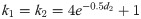
Comparison of effects between the cases of tracking (r > 0) and non–tracking (r = 0): inline–type structure.(A,B) dependence of mean expression and noise intensity on the green loop length for a fixed tracking ratio (r = 0.1), where the dashed lines correspond to the side-by-side loops; (C,D) dependence of mean expression and noise intensity on tracking ratio for a fixed green loop length; (E,F) three–dimensional pseudo diagrams for dependence of the mean expression level/the noise intensity on both the loop length and the tracking ratio, where the color change in the bar represents the change in the mean level or in the noise. Parameter values are set as d1 = 1500, λ21 = λ32 = λ34 = λ41 = 0.3, μ = 10, δ = 1, r = 0.1, k1=k2=4e−0.5d2+1 with d2 ∈ (0,10000) in (A) and (B) but k1=k2=4e−0.5d1+1 with d1 ∈ (0,10000) in (C) and (D).